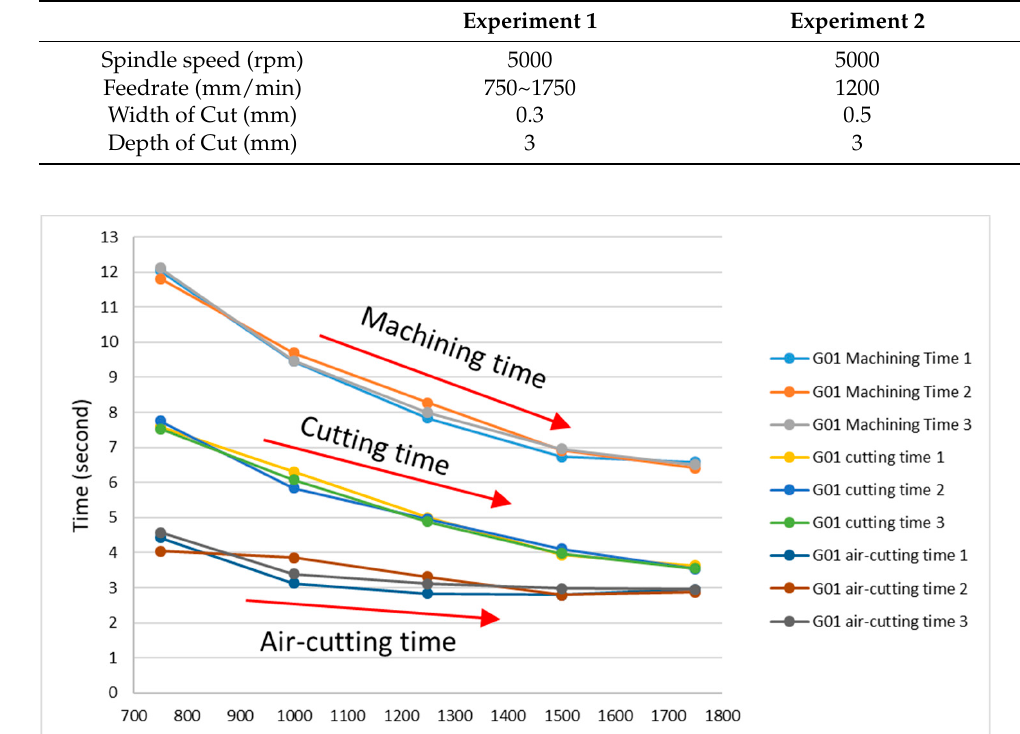
Figure 10. Results of verification experiment 2.